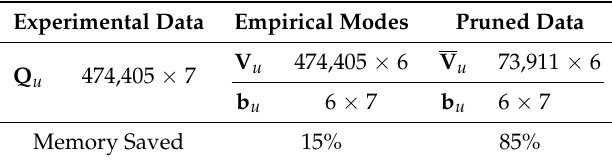
Table 1. Size of the matrix stored at each step of the data